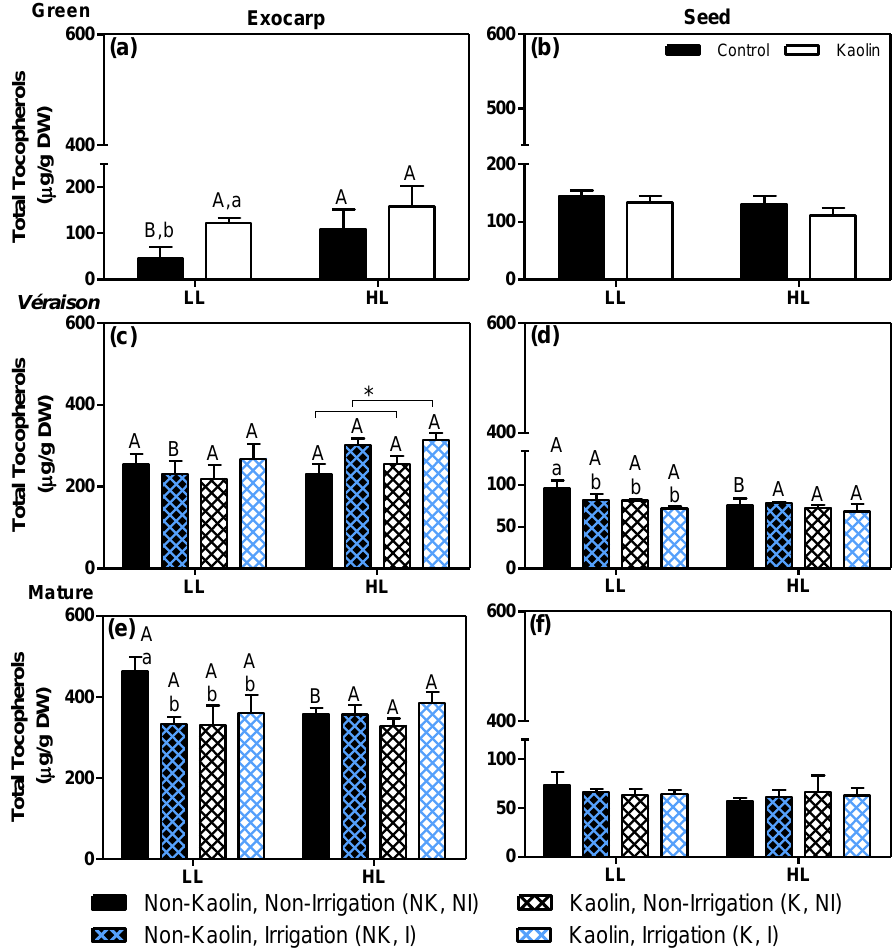
Figure 8. Total tocopherol contents (sum of the three main tocopherols detected, mean values + SD of n = 3 or 4) in exocarps ( a , c , e ) and seeds ( b , d , f ) of berries grown in either low light (LL) or high light (HL) microclimate conditions in the canopy. Kaolin (K) or no kaolin (NK) was applied to the plant leaves before fruit set; after green berries were developed, plants were either irrigated (I) or non-irrigated (NI). Samples were collected at three development stages: green ( a , b ), véraison ( c , d ) and mature ( e , f ). Statistical notations above the bars: at each developmental stage, the capital letters refer to differences between the two light microclimates within the same treatment, while the lowercase letters refer to differences between treatment combinations within the same light microclimate (bars with no or a common letter indicate no significant differences; two-way ANOVA, p ≤ 0.05). Notation with an asterisk means that only one factor (in this case the irrigation) was